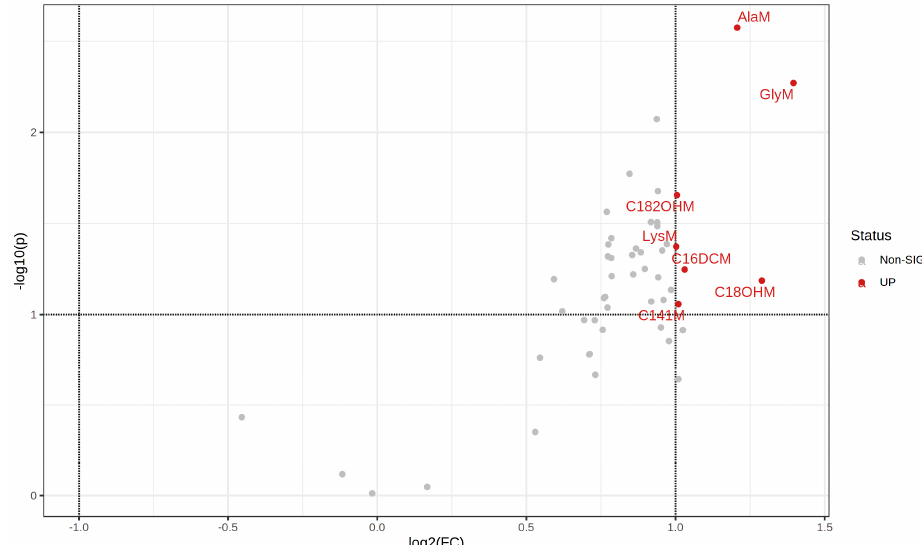
Figure 2. Upregulated metabolites in HCRs compared to LCRs. The metabolites were calculated by volcano plot with a fold change (FC) threshold of ≥ |2| and Wilcoxon rank test p -value threshold of 0.1. The red circles represent the seven upregulated metabolites above the thresholds for the HCRs vs. LCRs comparison.